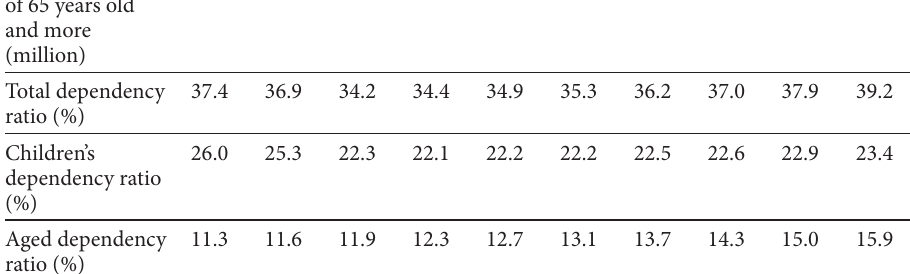
The data source: China National Bureau of Statistics. The data for 2015 is from the 1% sample sur- vey data, the data for 2010 is the national census data and other data is 0.1% of the sample survey data of each province in China.